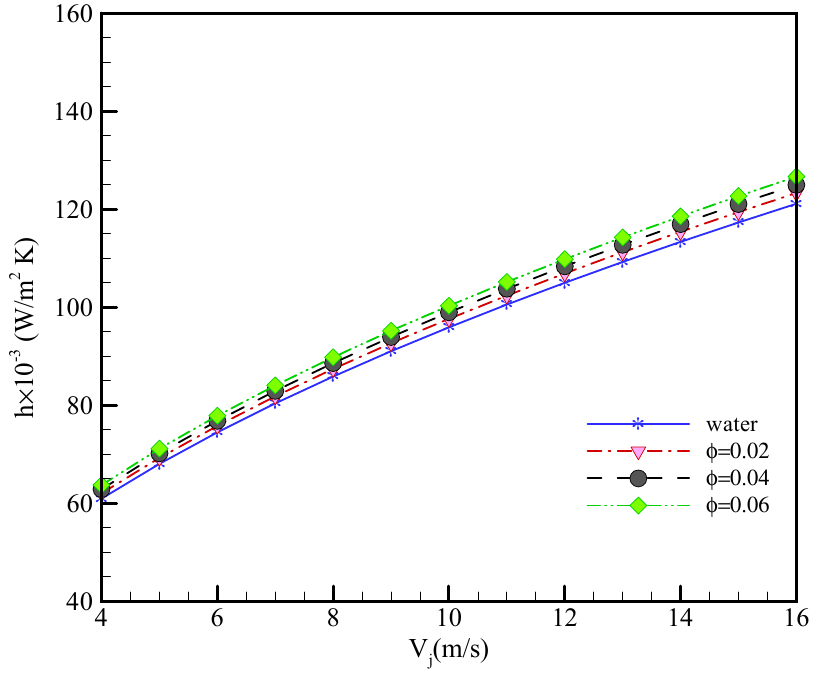
Figure 12. The variation of heat transfer coefficients with respect to jet velocity for nanofluid with different particle volume fraction (T j = 25 °C).